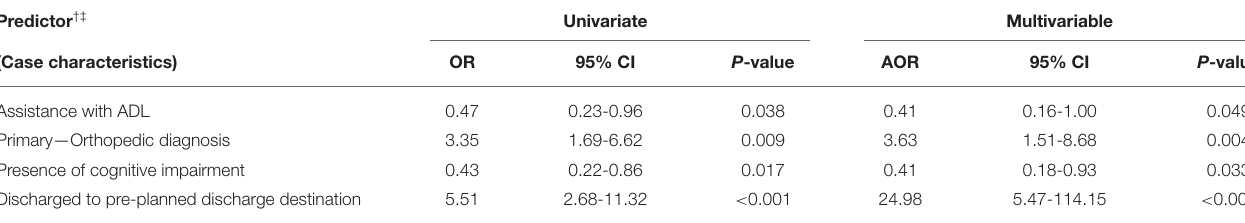
TABLE 2 | Multivariable analysis for Outcome = home (FINAL).